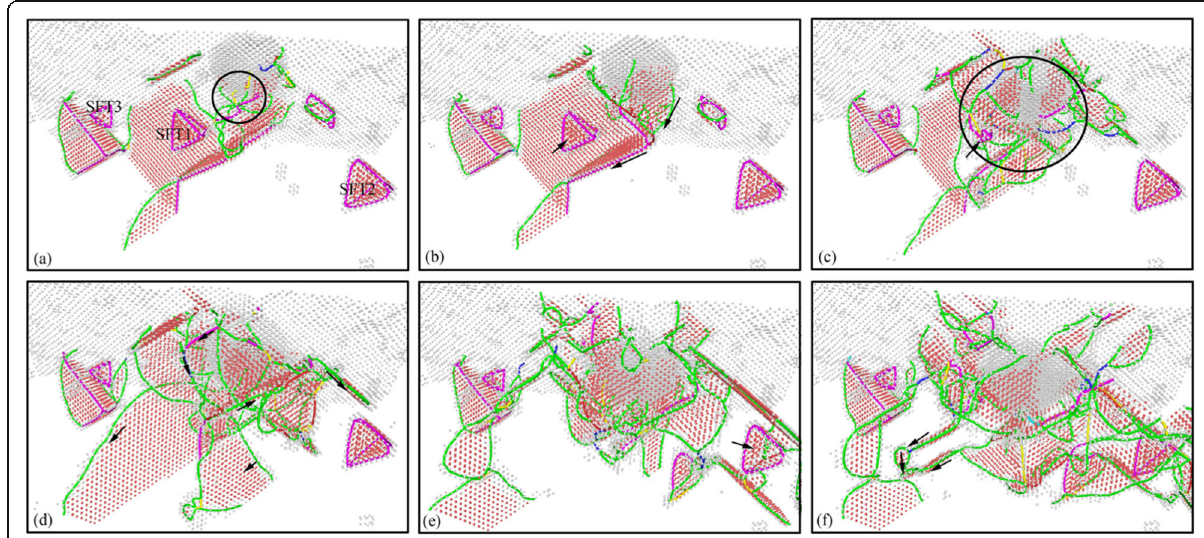
Fig. 8 Distribution of subsurface dislocations in loading process of nano-indentation (color online). The corresponding indentation depths of a – f are 0 nm, 0.5 nm, 1 nm, 2 nm, 3 nm, and 4 nm, respectively. Color scheme: deep blue for perfect dislocations, green for Shockley dislocations, pink for Stair-rod dislocations, yellow for Hirth dislocations, light blue for Frank dislocations, and red for unidentified dislocations